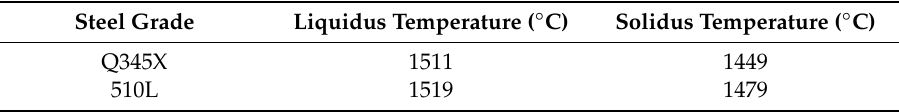
Table 4. Liquidus and solidus temperatures of the